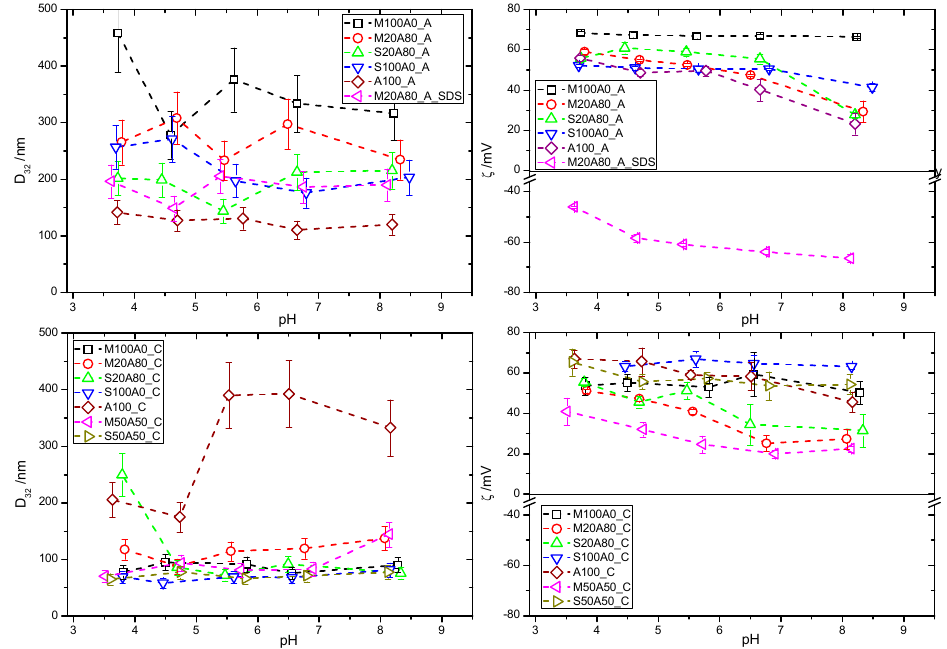
Figure 1. Sauter diameter, D 32 ( left ) and ζ -potential ( right ) for the polymer dispersions with anionic (top row) and cationic (bottom row) initiator (see Table 1 for compositions).